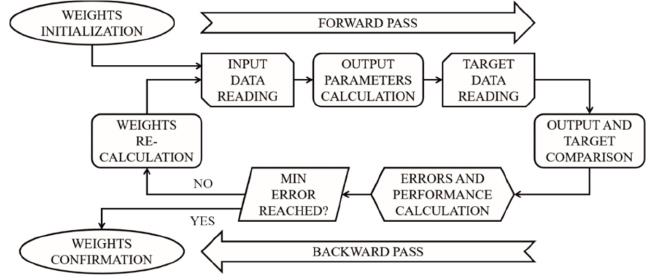
Figure 1. Iterative cycle performed by the backpropagation algorithm.